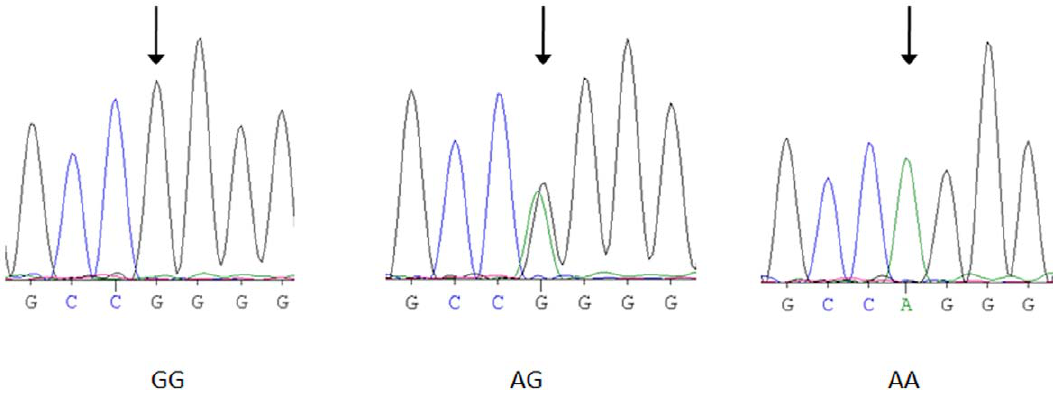
Figure 2. AGT G-6A polymorphism genotyping by direct sequencing. The arrows indicate the polymorphic site of GG, AA and AG genotypes.